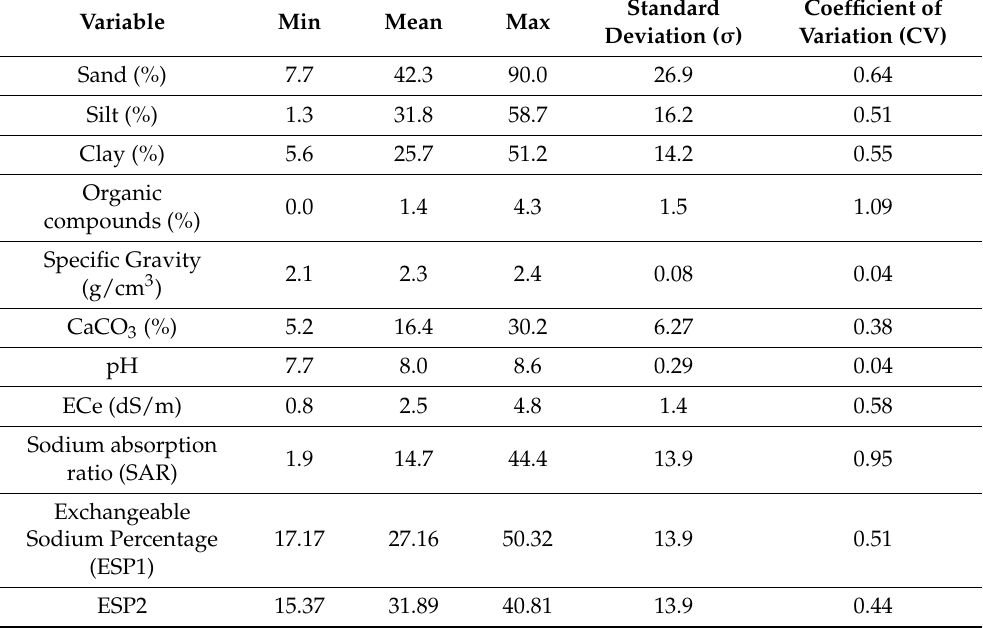
Table 4. Physiochemical laboratory analysis for saline soil sampling/ground control points for the accuracy assessment of the soil salinity maps produced by the various indices, as explained in Table 3.